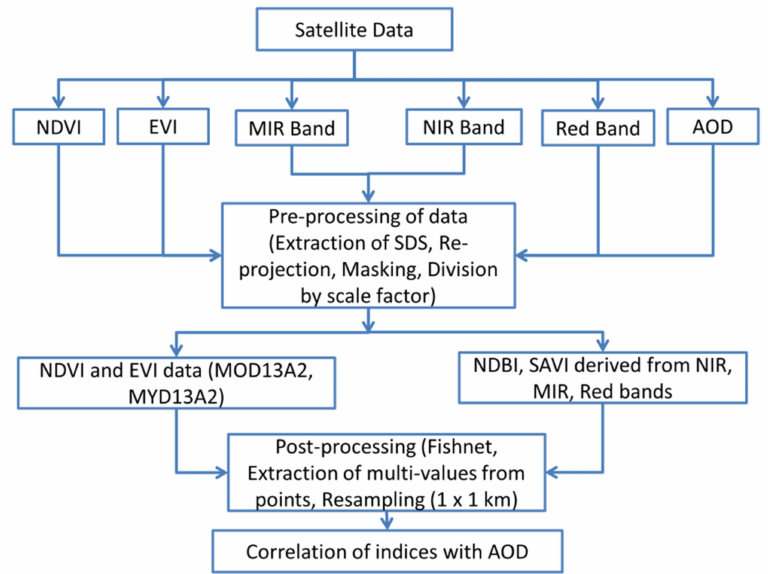
Figure 2. Flowchart of Methodology.